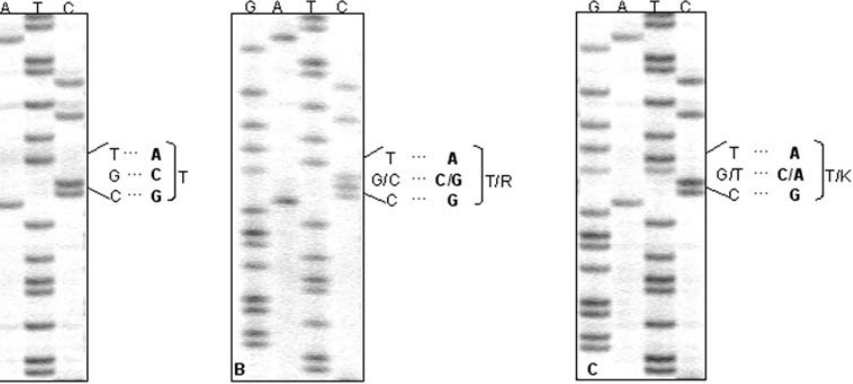
Figure 1. Sequence analysis of PRNP in three patients with prion diseases. The coding region was sequenced using fluorescence-labeled primers on an automated sequencing system (LI-COR, Lincoln, Neb.). Short fragments of PRNP of (A) a patient with the normal codon 188, (B) patient A with the T188R mutation and (C) patient B with the T188K mutation are shown using a primer for the sequencing that reads the antisense strand.